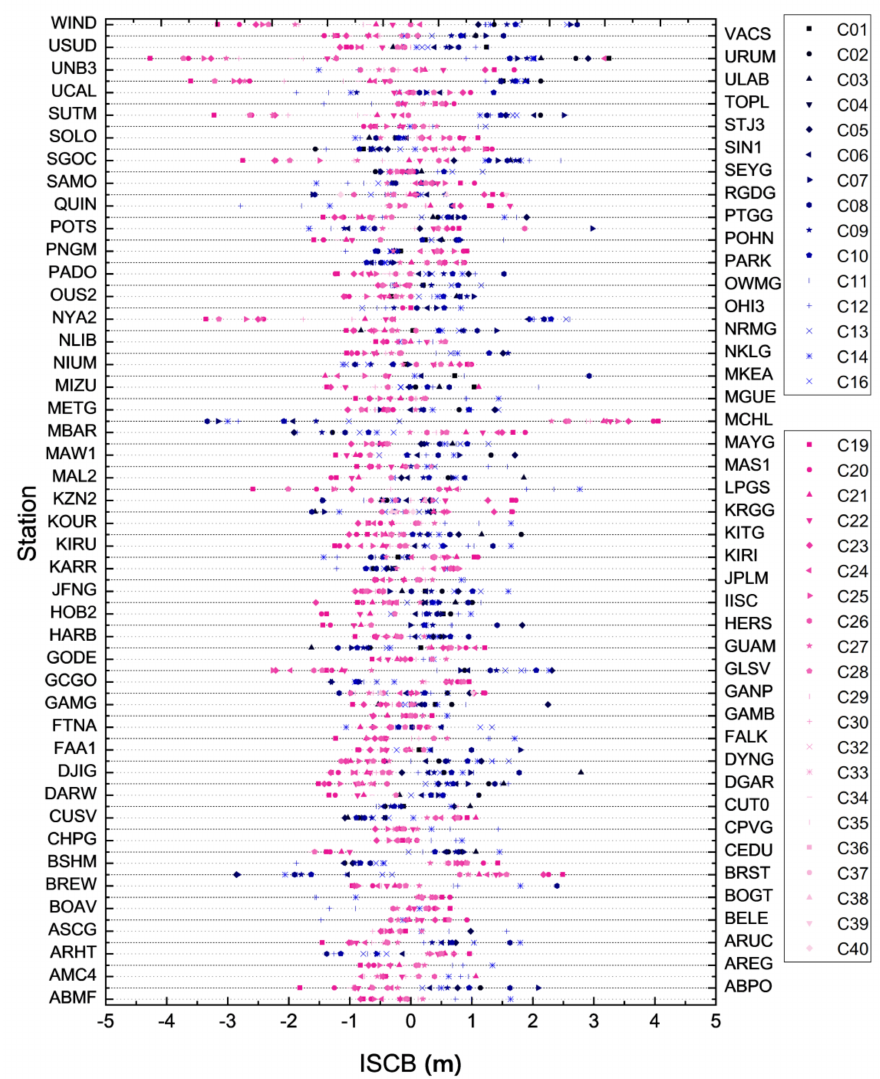
Figure 5. BDS, 2 and BDS, 3 ISCBs clustering for the 90 stations